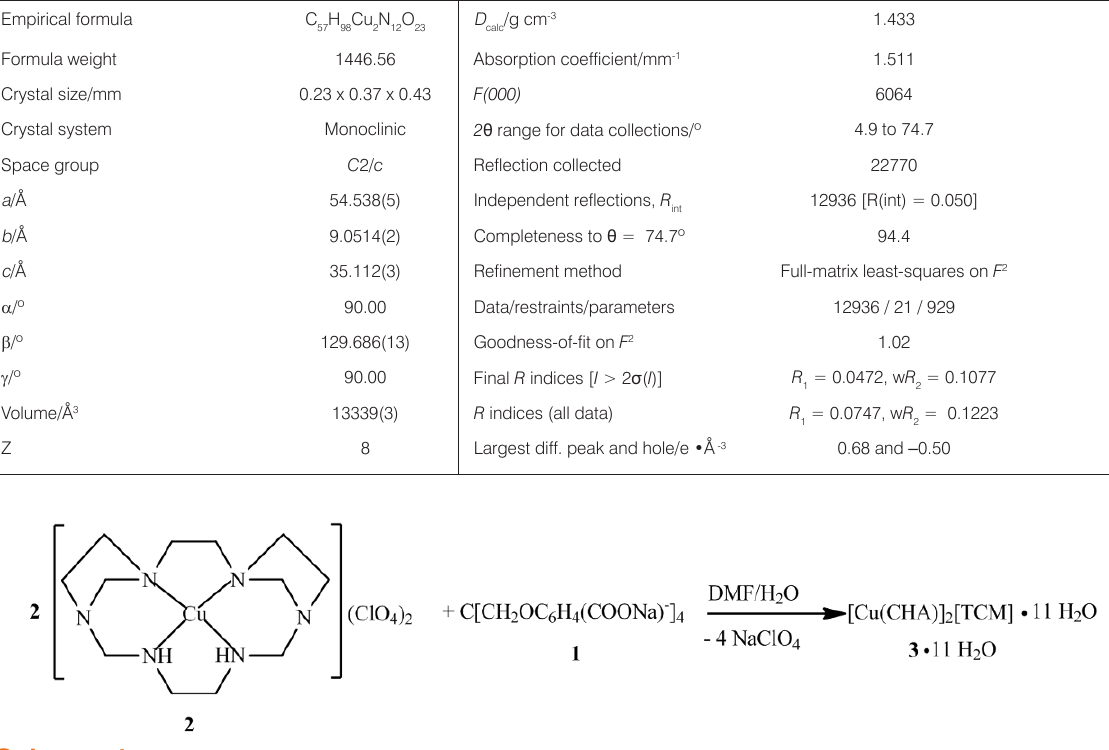
Table 1. Crystal data and structure refinement for compound 3•11H